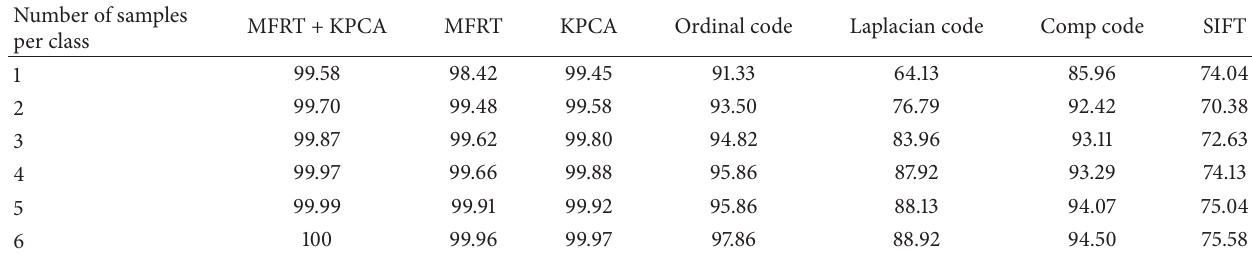
Table 6: Accuracy measures from Poly U left and right hand multispectral palm print image.